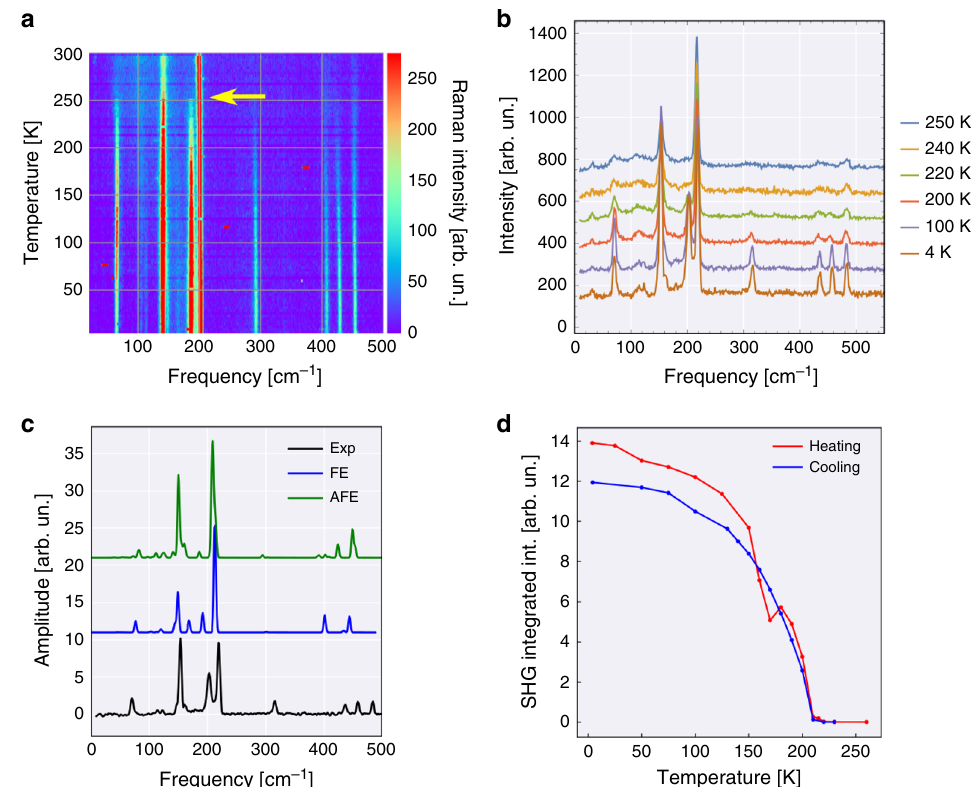
Fig. 4 Phase transition in CuInP 2 Se 6 detected by optical spectroscopies. a Temperature dependent Raman spectroscopy of a CuInP 2 Se 6 crystal, represented as a heat map. The phase transition below ~250K is clearly visible (yellow arrow). b Individual Raman spectra at several measured temperatures. c Comparison of the Raman spectrum at 7 K to the DFT calculations for the ferroelectric (FE) and antiferroelectric (AFE) con fi gurations. d The intensity of second harmonic generation (SHG) across the phase transition at 200 antiferroelectric end-states: in ferroelectrics, polarization drops to zero at the domain wall ( x = x 0 in Supplementary Eq. (18)), while